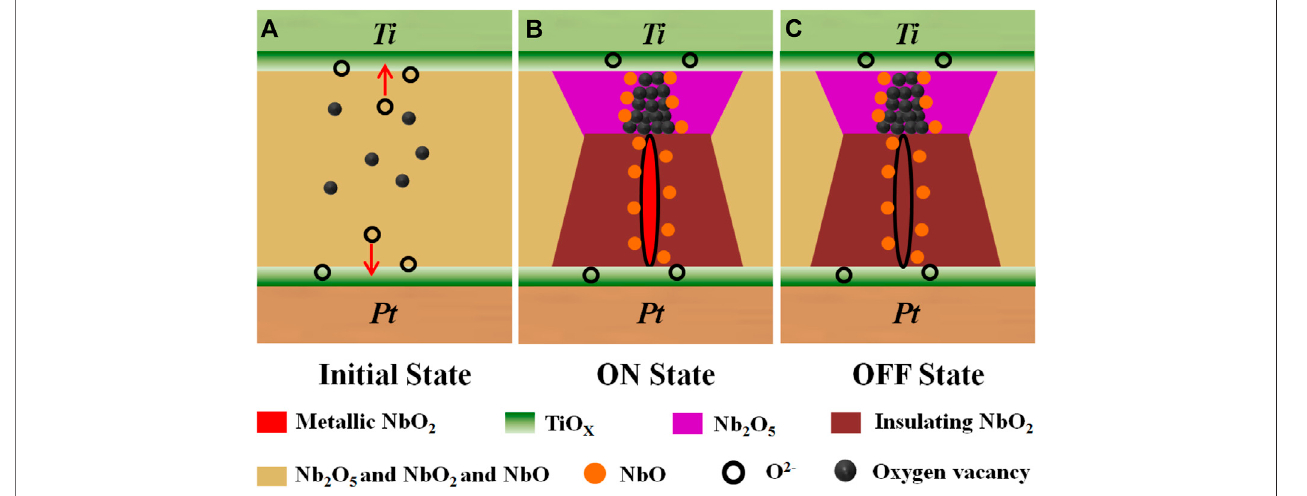
FIGURE 4 | (A) The model as an initial state of the Ti/NbO x /Ti/Pt device; (B) and (C) schematic diagram of the ON state and OFF state of the device.